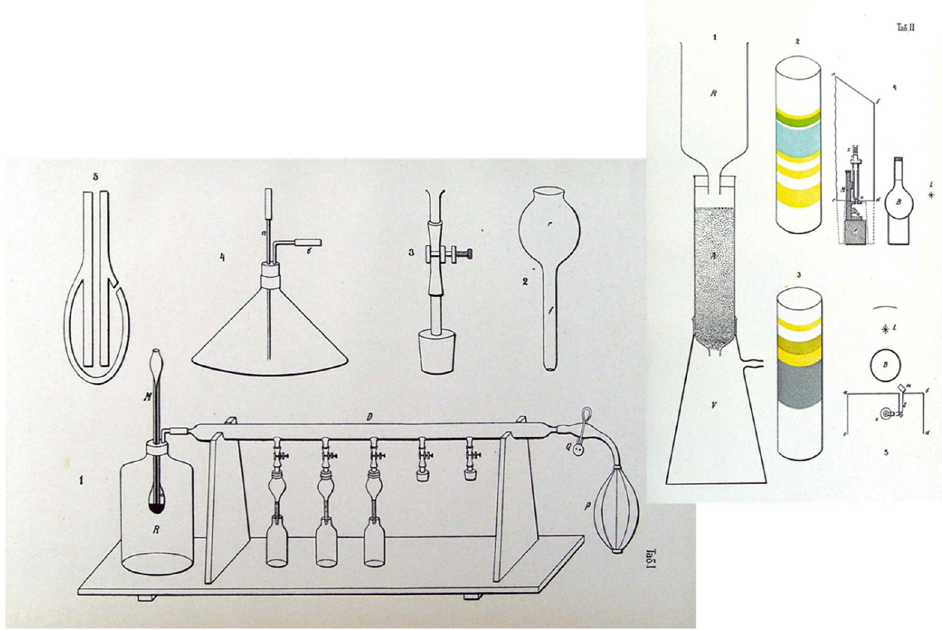
Figure 3. Chromatographic set and the concept of separation of natural dyes according to M.S.